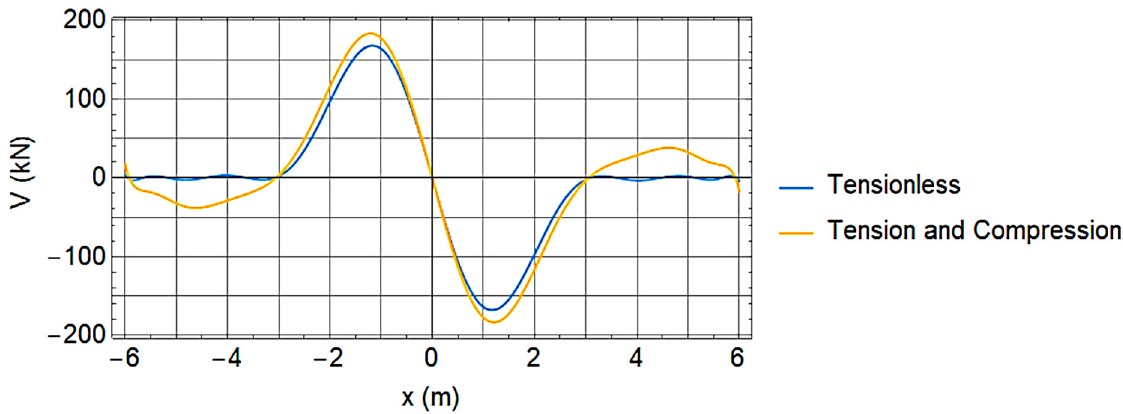
Figure 9. The shear force diagram for the symmetric case ( X (cid:3365) = 2L/5(cid:4667).